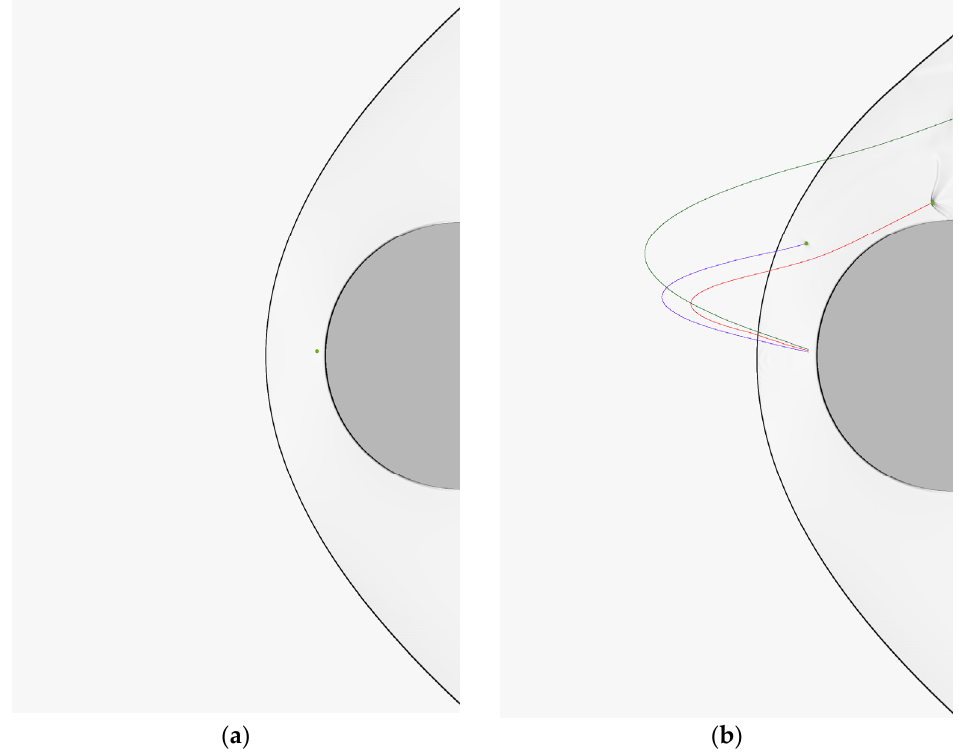
Figure 3. Schlieren images at the starting ( a ) and final ( b ) times.